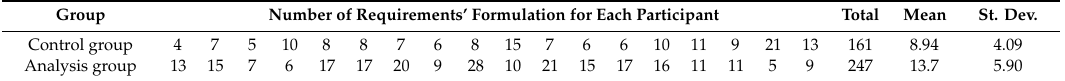
Table 7. Number of requirements generated by each